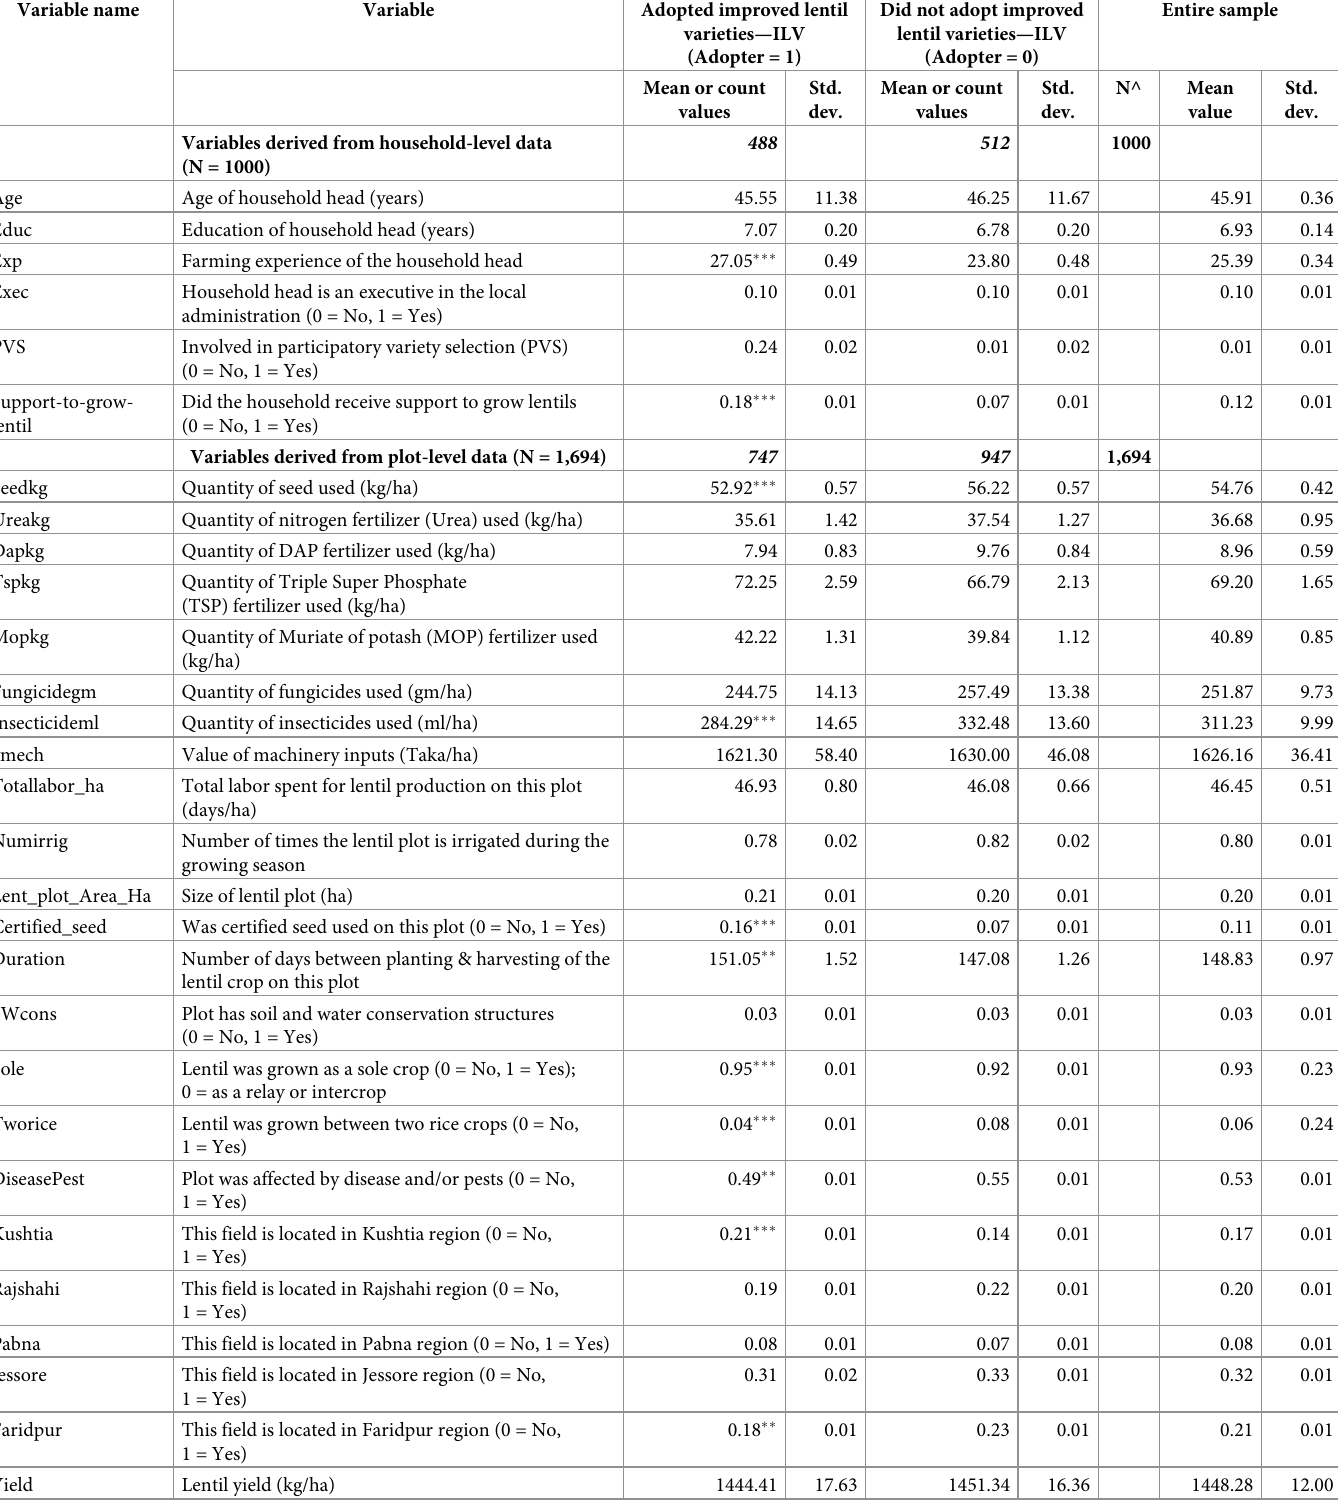
Table 3. Summary statistics for variables included in the models. Variable